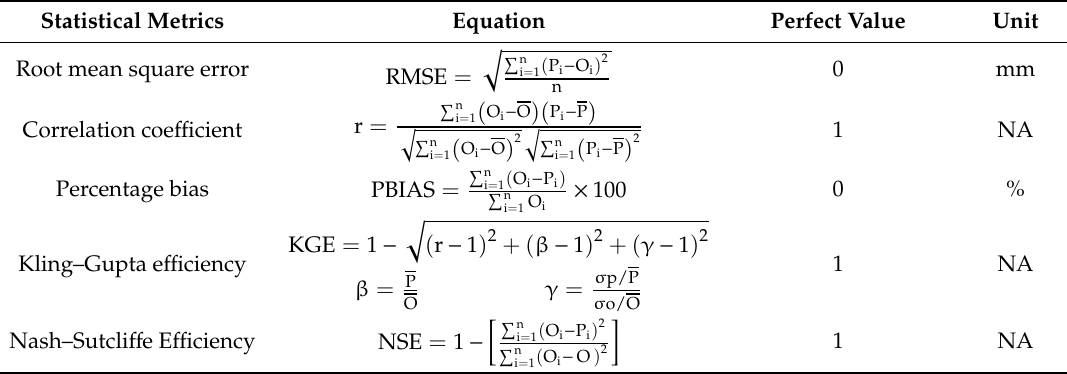
Table 1. Statistical metrics for hydrological and meteorological